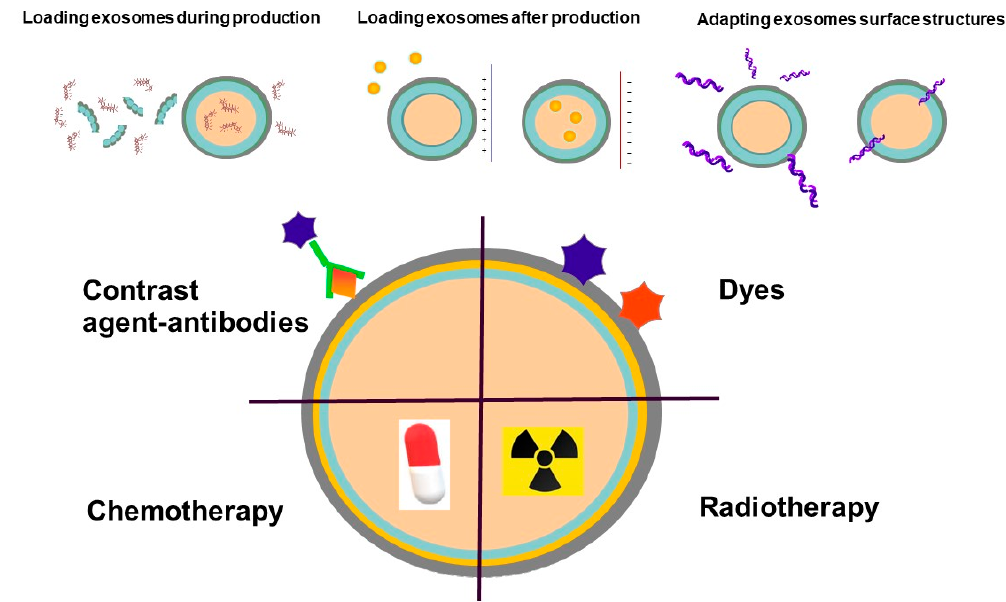
Figure 3. Strategies for EVs modification. A direct EVs modification strategy is to permeabilize the vesicle membrane to allow the active loading of molecules into the EVs interior, an approach that has been exploited for drug delivery. Agents can be incorporated into EVs, for instance, as contrast media or radionuclide.